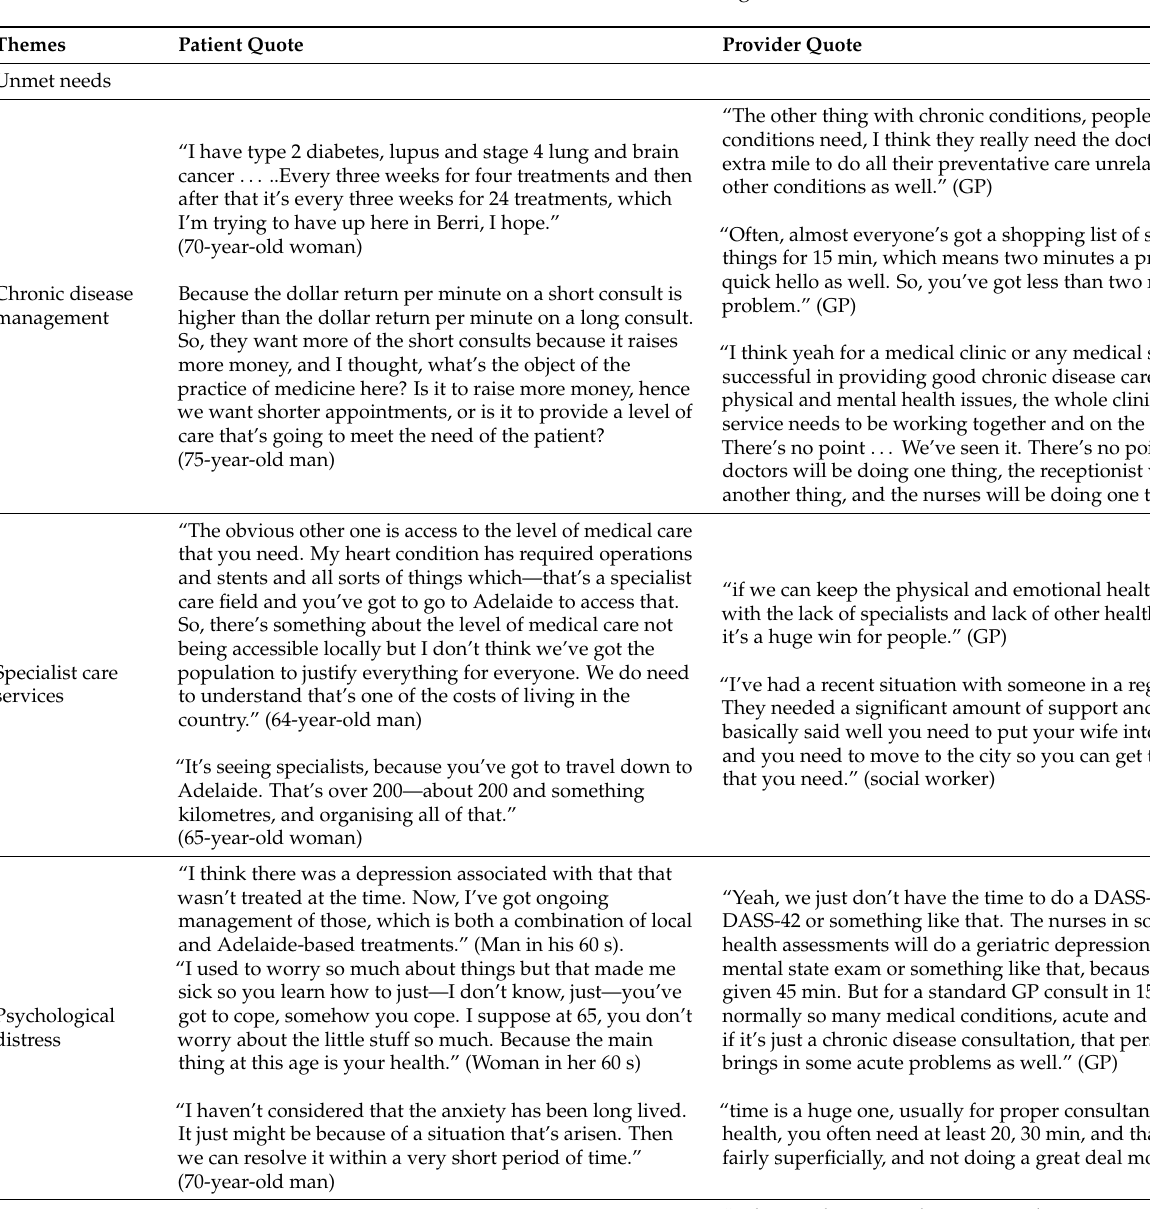
Table 2. Unmet health needs, access challenges, and facilitators to health services